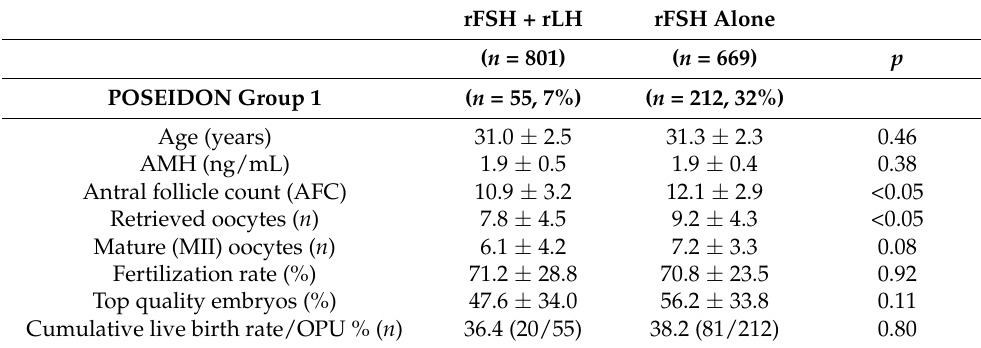
and percentage, as